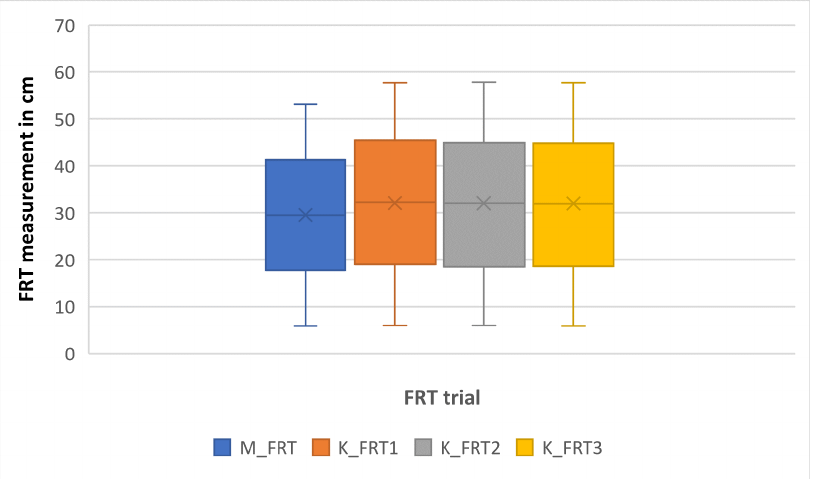
Figure 12. Box plot of the FRT measurements by the experimental system (K_FRT) and manually (M_FRT) in Experiment